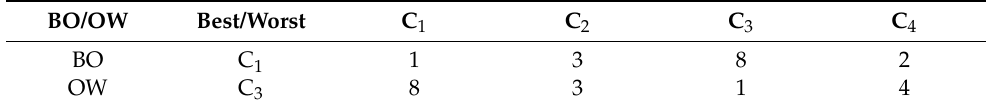
Table 2. The vectors of comparison